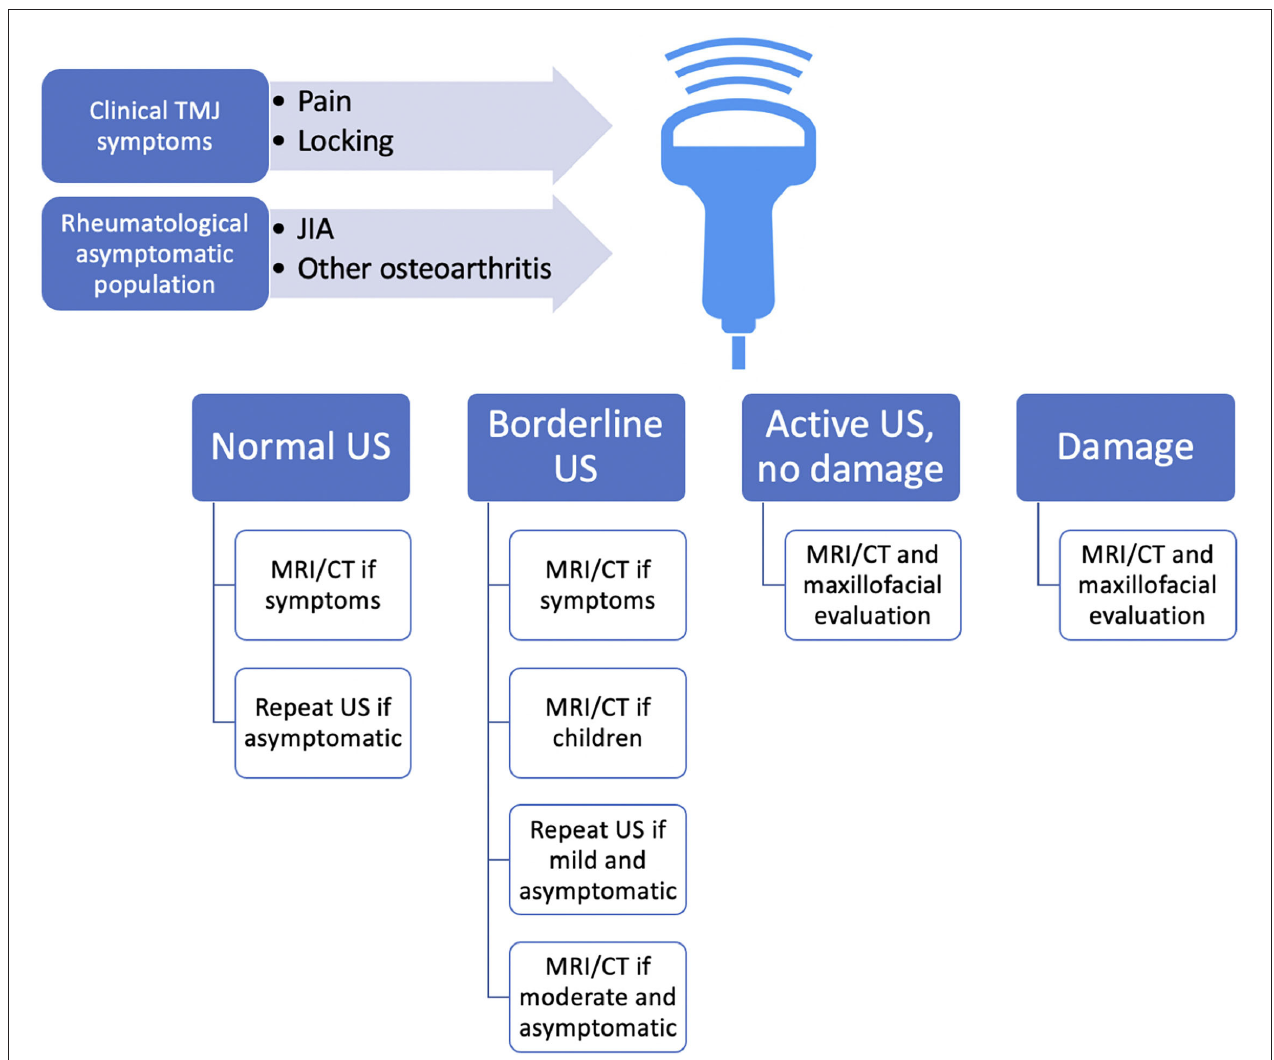
FIGURE 4 | Overview of possible proposed employment of US in TMJ pathology screening as a first-level examination, guiding choice on the follow-up methods. As no validated protocol suggests any early imaging methodic screening in the rheumatological population at-risk for TMD, and also TMD may present rather asymptomatic during the early stages of the disease, we propose US as an “entry-level” method, which is rapidly accessible and of relatively low cost. US could approach all the patients with rheumatic conditions and hopefully also RA-at-risk patients, even if asymptomatic, and of course those with TMJ symptoms. Because US was found to be specific, but not particularly sensitive, we advocate MRI execution even for borderline suspicious findings at US, as baseline MRI could improve anatomic US accuracy during the follow-up. CT, computed tomography; JIA, juvenile idiopathic arthritis; MRI, magnetic resonance imaging; RA, rheumatoid arthritis; TMJ, temporomandibular joint; US,